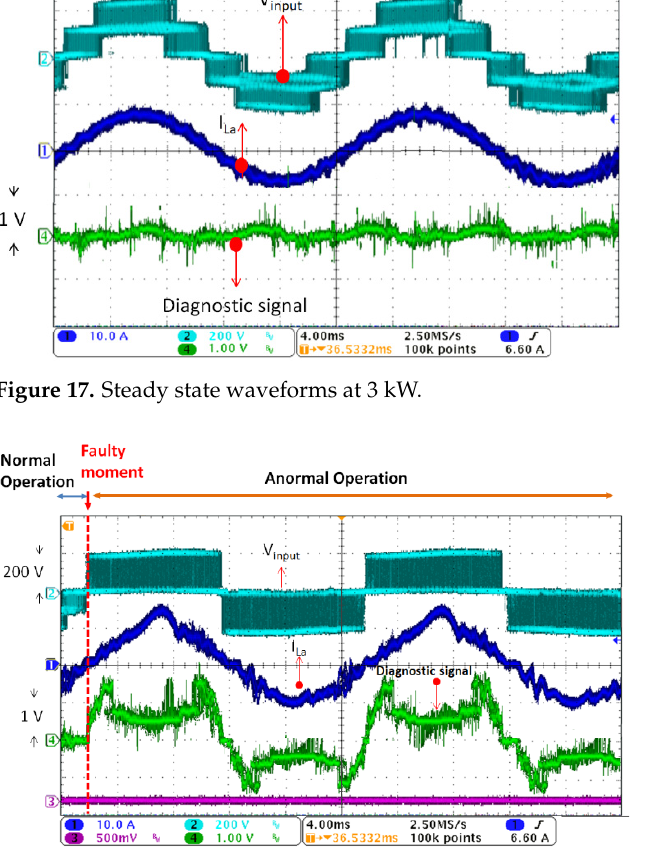
Figure 18. Experiment results for short-circuit fault condition on T 1 without reconfiguration.